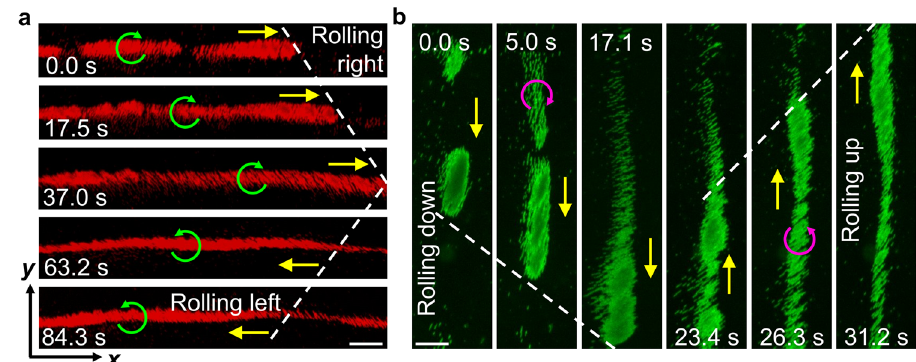
Fig. 3 | Bidirectional rolling of microchains along the acoustic virtual wall. a Bidirectional rolling motion (the direction is indicated by a yellow arrow) along the x -axial acoustic virtual wall upon fl ipping the rotational direction of the mag- netic fi eld (green curved arrow). The white dotted line denotes the net displace- ment. b Bidirectionalrollingmotionalongthe y -axialacousticvirtualwall.Thepink